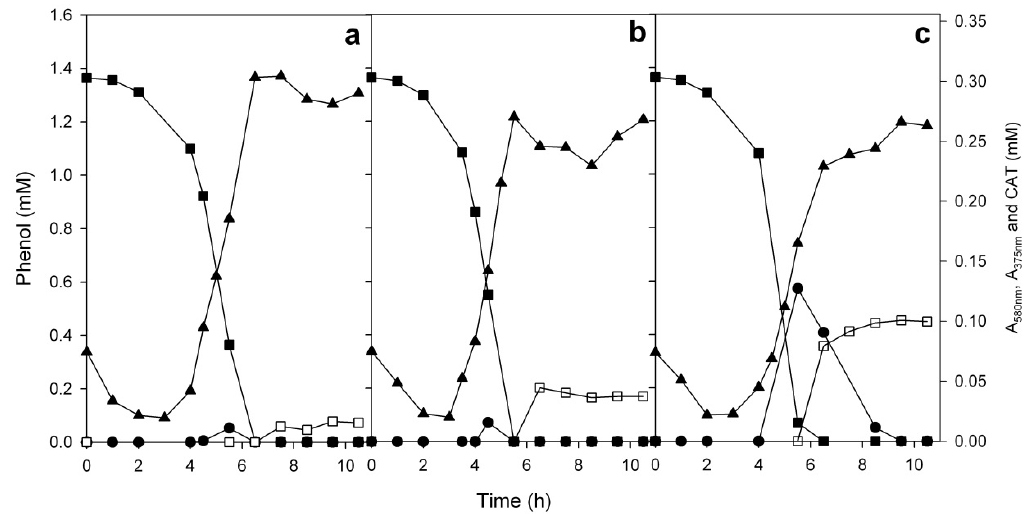
Figure 6. Growth of the strain ICP1 on 1.3 mM phenol incubated at 25 ( a ), 30 ( b ), and 35 ( c ) °C. Growth ( ▲ , measured as absorbance at 580 nm), degradation of phenol ( ■ ) and accumulation of catechol (CAT, ● ) and colored intermediate ( □ , measured as absorbance at 375 nm). Concentrations of the substrates and intermediates are the averages of triplicate determinations; the combined standard uncertainties of the results were between 2.1% and 3.4%.